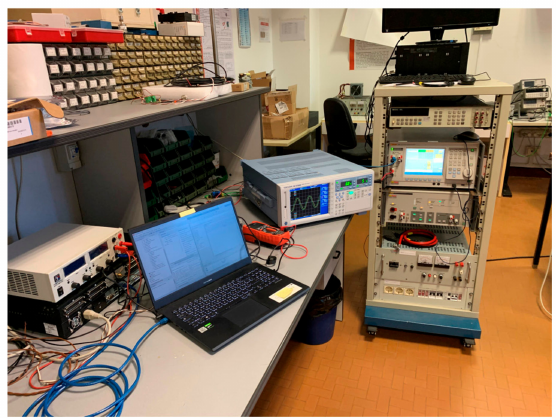
Figure 8. Picture taken of the laboratory environment during the RTS